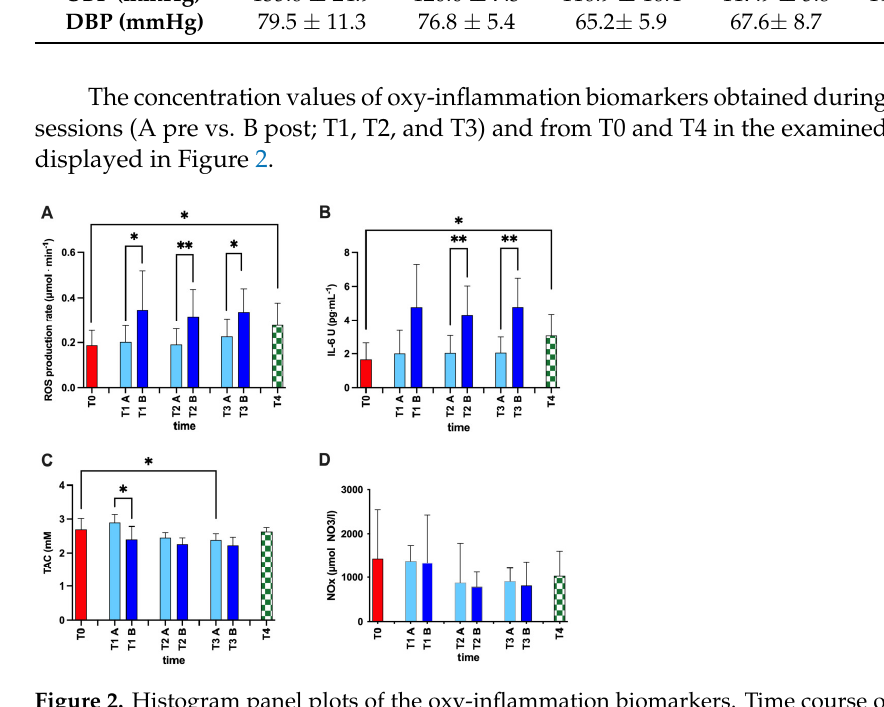
Figure 2. Histogram panel plots of the oxy-inflammation biomarkers. Time course of ( A ) reactive oxygen species (ROS), ( B ) interleukin (IL-6), ( C ) total antioxidant capacity (TAC), and ( D ) NO metabolites (NOx) at: T0, basal measure, before the season; T1, at the start of training season; T2, the middle period of the season; T3, the end of the season; and T4, two months after the end of the season. Values recorded from pre- (TA) and post- (TB) training sessions are also reported. Data are expressed as mean ± SD. Statistically significant differences comparison are displayed as: *, p < 0.05; **, p < 0.01.